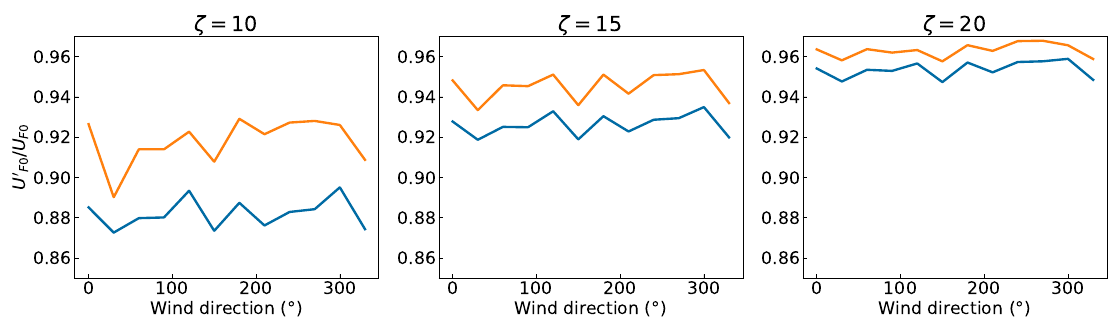
Figure 16. Farm-upstream wind speed reduction factor for all wind directions at U F 0 = 10 m/s, for Case A (blue) and Case B (orange).